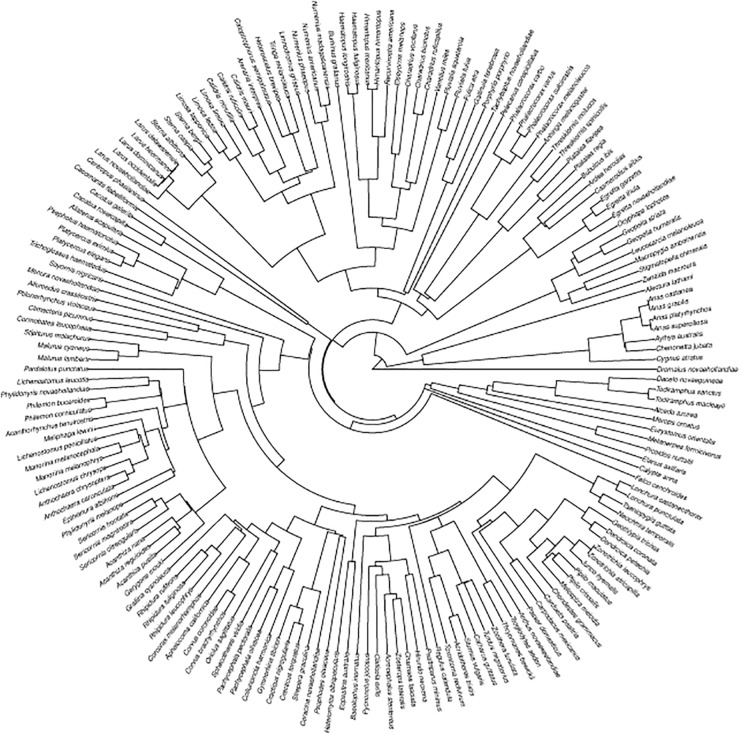
Phylogenetic hypothesis of the 178 avian species included in the present study.